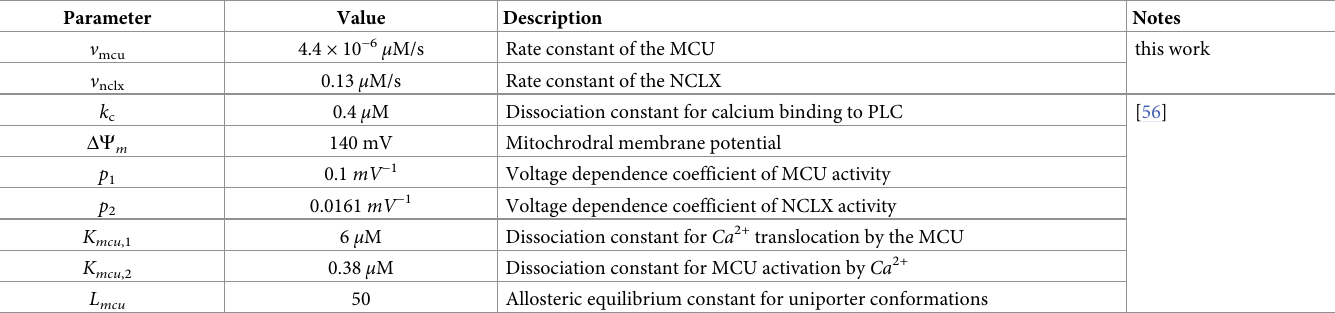
Table 2. Mitochondria model parameters. MCU parameters taken from [56] and adjusted based on [33] Figure 2D. Parameter